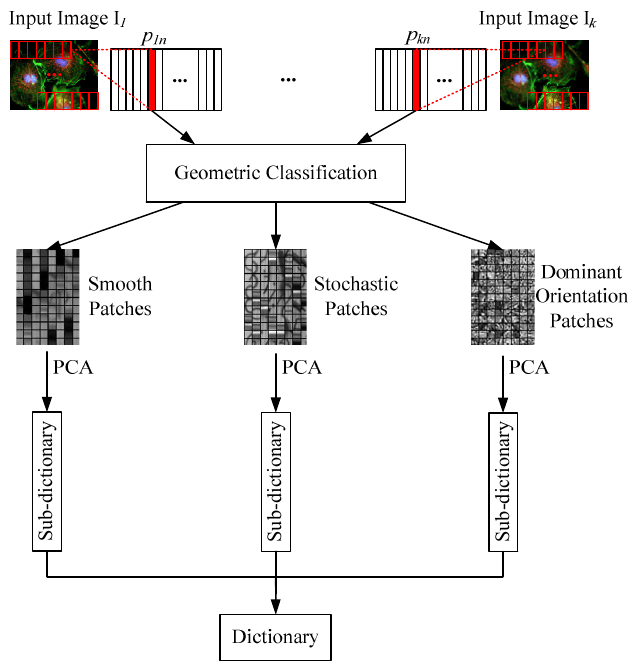
Figure 1. Geometric Dictionary based Image Fusion